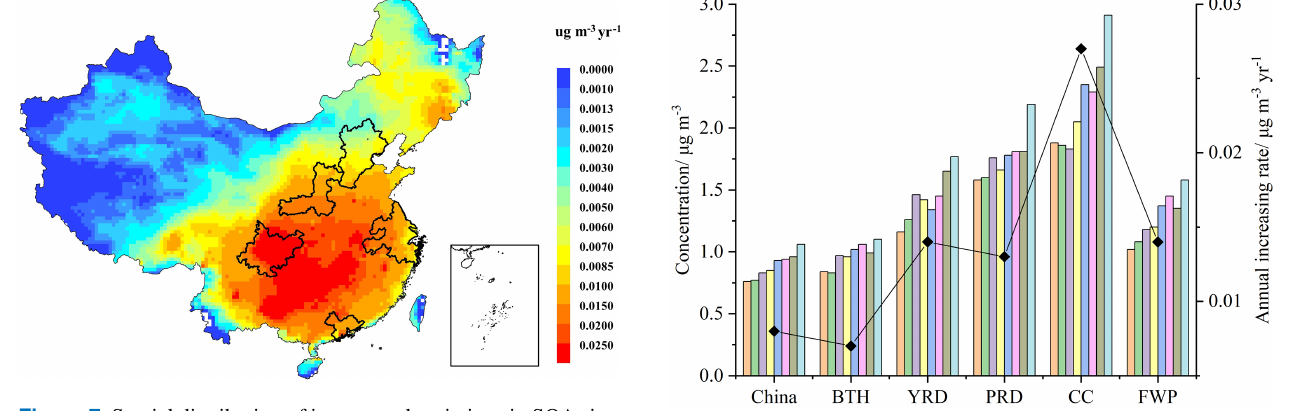
Figure 7. Spatial distribution of interannual variations in SOA sim- ulated using annual BVOC emission factors.